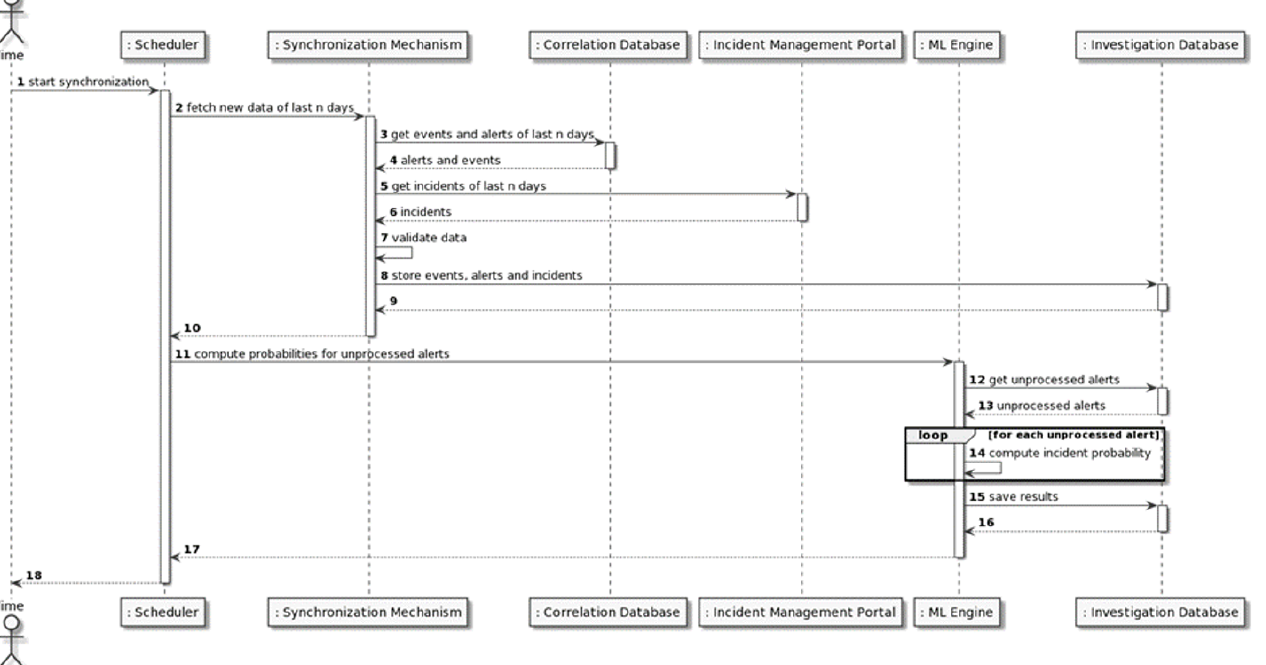
Figure 5. SMS-I Synchronization